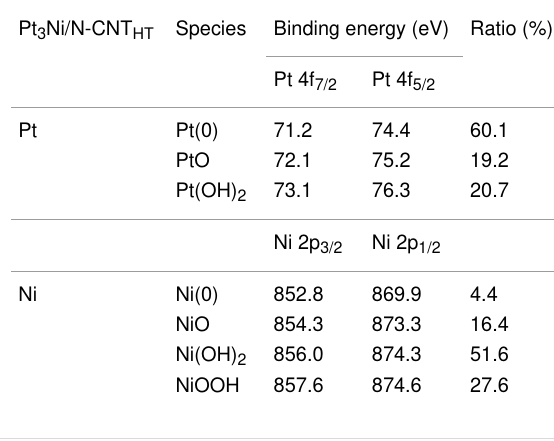
Table 6: Binding energies and ratio of Pt and Ni species obtained from XPS